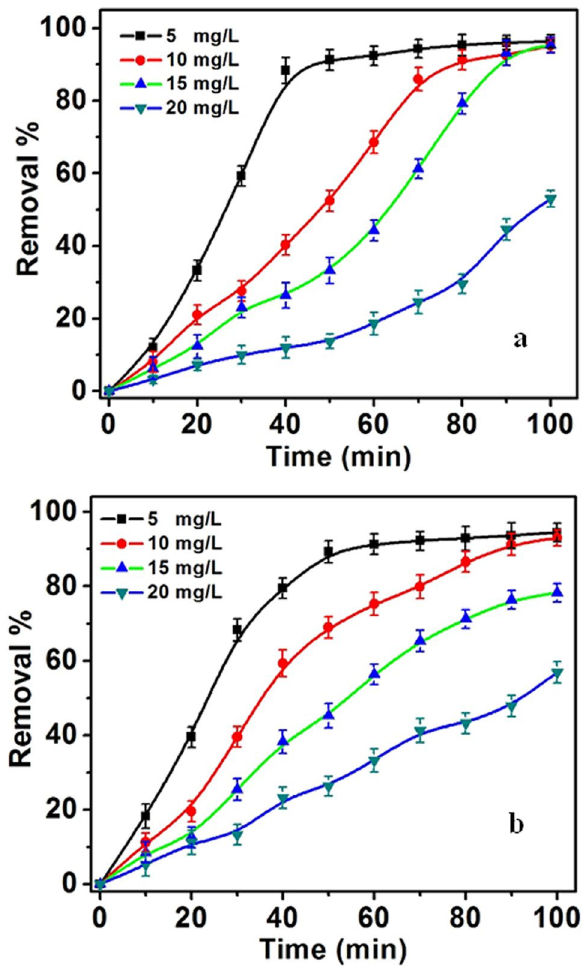
Figure 13. ( a ) Effect of initial concentration of MO on the bleaching; ( b ) degradation, the concentration of CPA/N-SWCNTs-GO-CE/CuO of 50 mg/L, pH 6.2 and time 100 min.